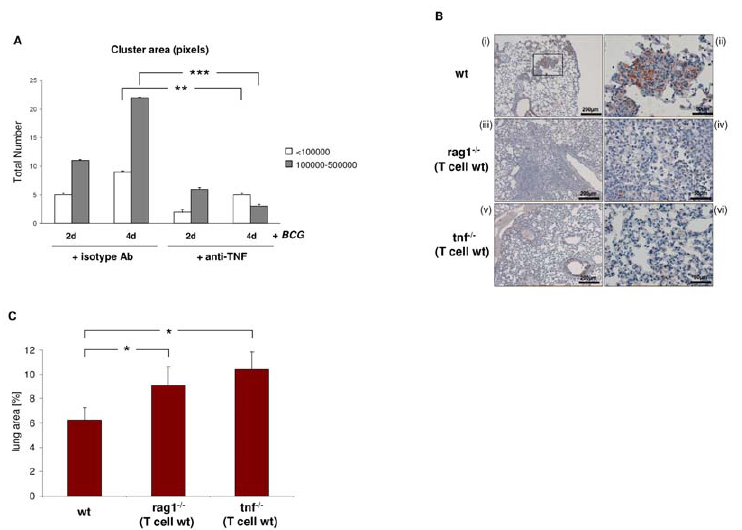
Figure 8. Loss of the macrophage-TCR in the presence of functional T cells results in disorganized granulomas and CCL2 suppression in murine pulmonary tuberculosis. ( A ) TNF blockade decreases the number and size of macrophage clusters induced by BCG infection in vitro . IFN c macrophages were infected with M. bovis BCG in the presence of the anti-TNF antibody infliximab (50 m g/ml) or an equal amount of an isotype antibody (anti-CD20) for the indicated timepoints. Bar graphs represent total numbers of small ( , 100000 pixels) and large macrophage clusters (100000– 500000 pixels) that were formed. The area (number of pixels) of the macrophage clusters was determined from electronic images. The results (mean 6 SEM) are basedontheanalysis ofthree independentdonors. ** p , 0.01, ***p , 0.001. ( B ) Lung sections of wildtype(wt) mice demonstrating formationofcompact, well-circumscribed tuberculous lesions after four weeks infection with M. tuberculosis (i). A higher magnification of the boxed granuloma is shown in (ii). In contrast, chimeric rag1 –/– (T cell wt) mice that lack the macrophage-TCR but have intact T cells develop disorganized tuberculous lesions that are consistently